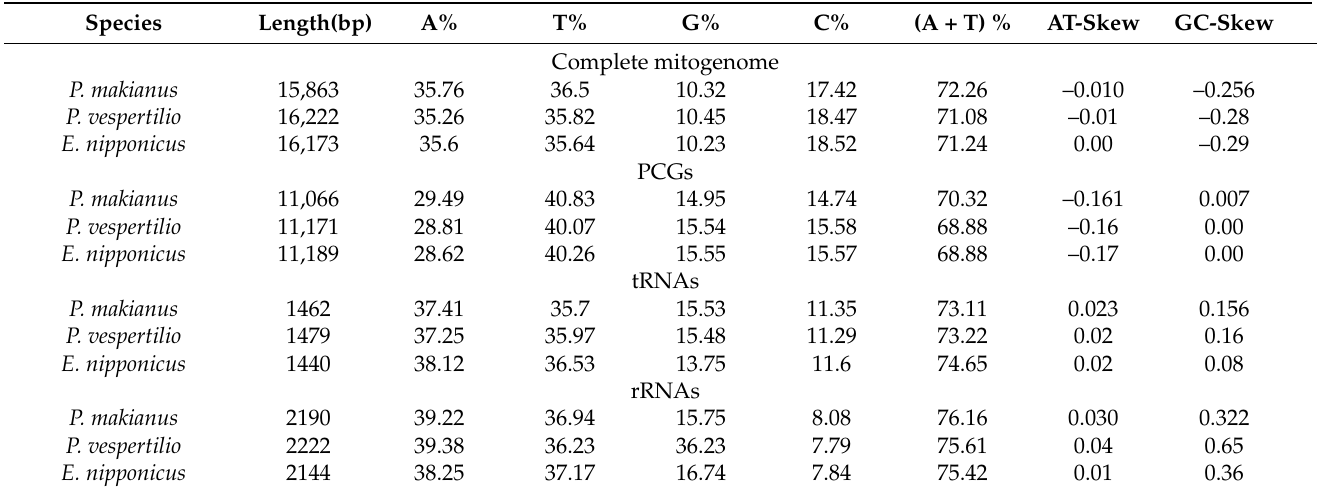
Table 3. Nucleotide composition of the mitogenomes of three Pilumnidae species. Species